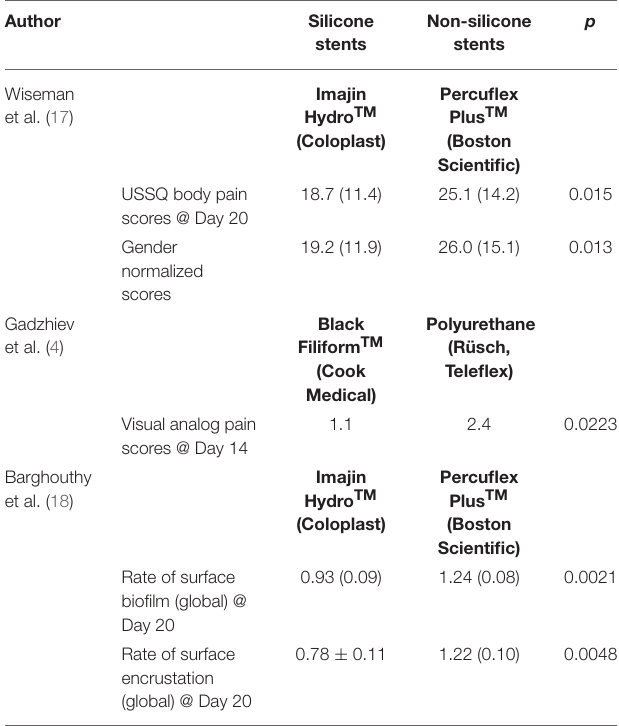
TABLE 2 | Silicone ureteral stents vs. non-silicone ureteral stents in pain scores and biofilm/encrustation formation (4, 17, 18).